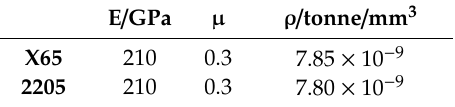
Table 1. Material properties of plate metal.